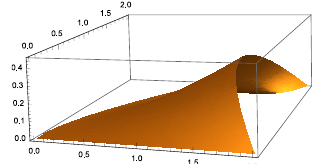
Figure 1: The ( q , h ) -Bézier